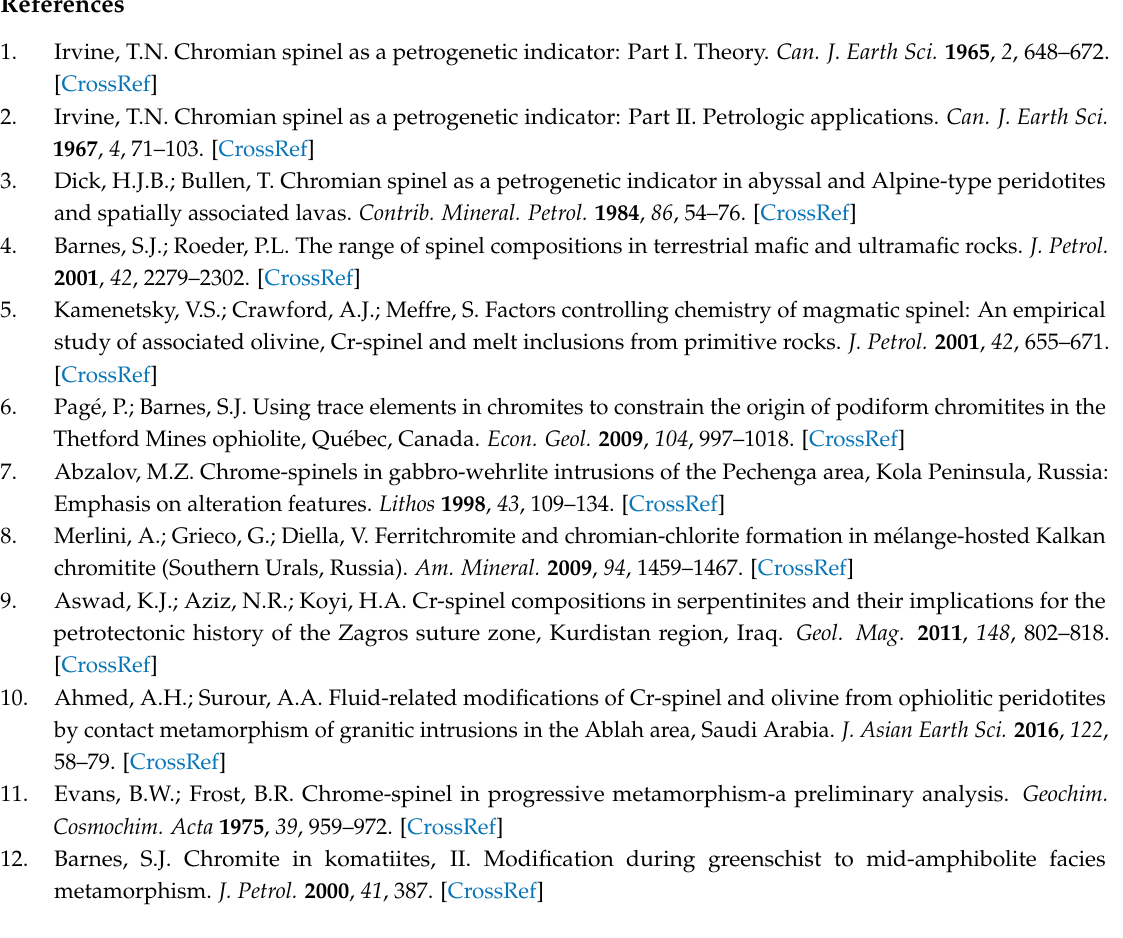
Figure S1: Compositional profiles of reverse zoned spinel in enstatite; Figure S2: Compositional profiles of reverse zoned spinel in tschermakite; Figure S3: Compositional profiles of reverse zoned spinel in phlogopite; Figure S4: Compositional profiles of reverse zoned spinel in olivine; Figure S5: Compositional profiles of zoned spinel among enstatite and olivine; Figure S6: Compositional profiles of zoned spinel among enstatite and phlogopite; Figure S7: Compositional profiles of zoned spinel among olivine and phlogopite; Table S1: Data of compositional profiles; Table S2: Supplementary coupled olivine and spinel compositions for temperature